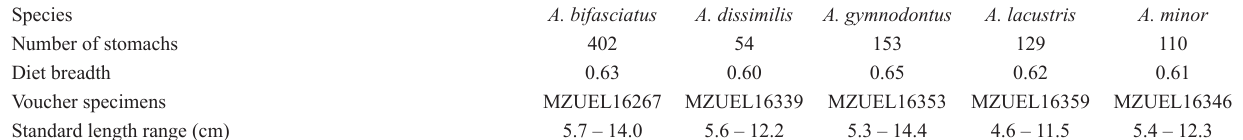
Tab. 1. Volumetric percentage (mL) of food items consumed by five species of Astyanax and their niche breadth in the Lower Iguaçu River and tributaries in Brazil. L=larvae; P=pupae;